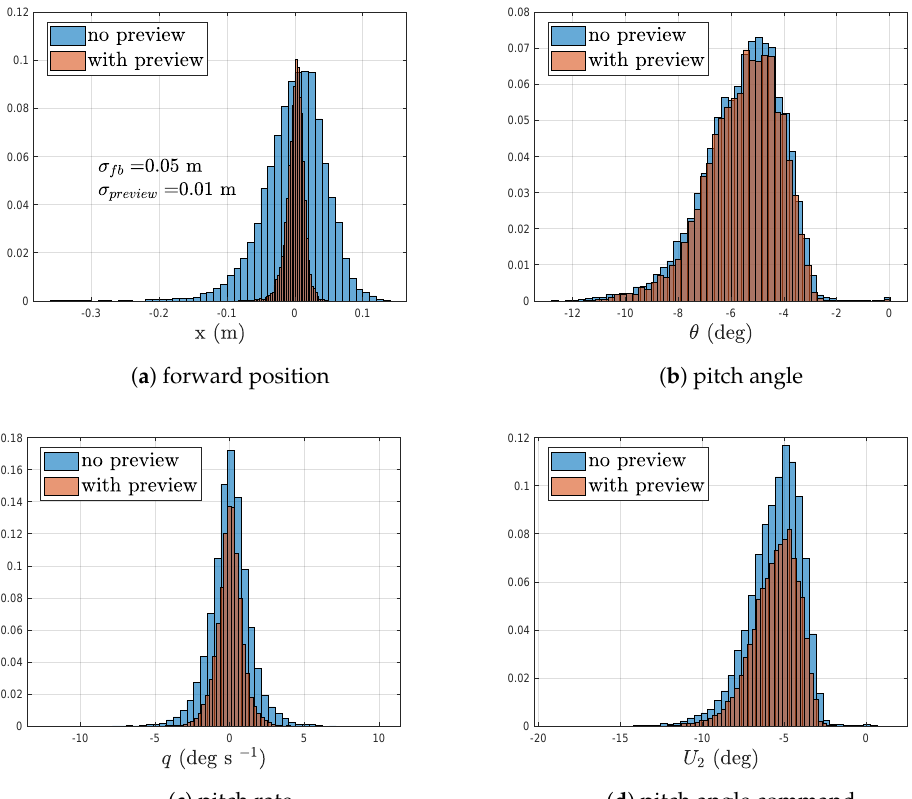
Figure 10. Histograms with and without wind preview control when aircraft is subjected to experi- mental wind data. Vertical axis for all plots is probability